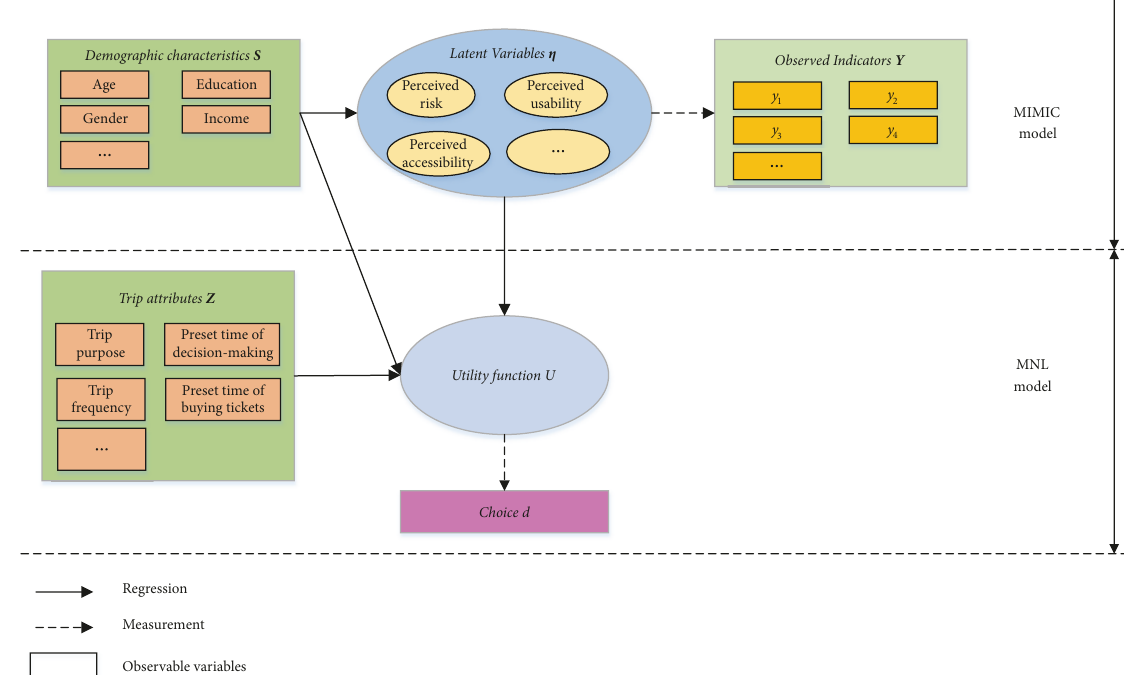
Figure 1: Framework of the integrated choice and latent variable